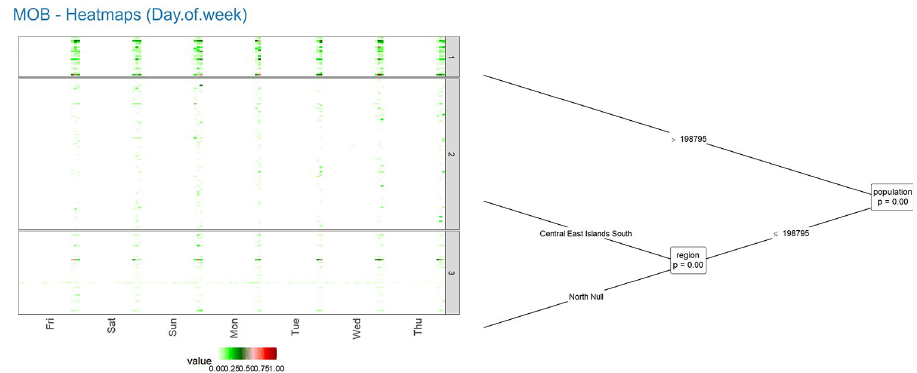
Fig 2. Clustering and forecasting Taiwan COVID-19 confirmed infection cases—Part 2.